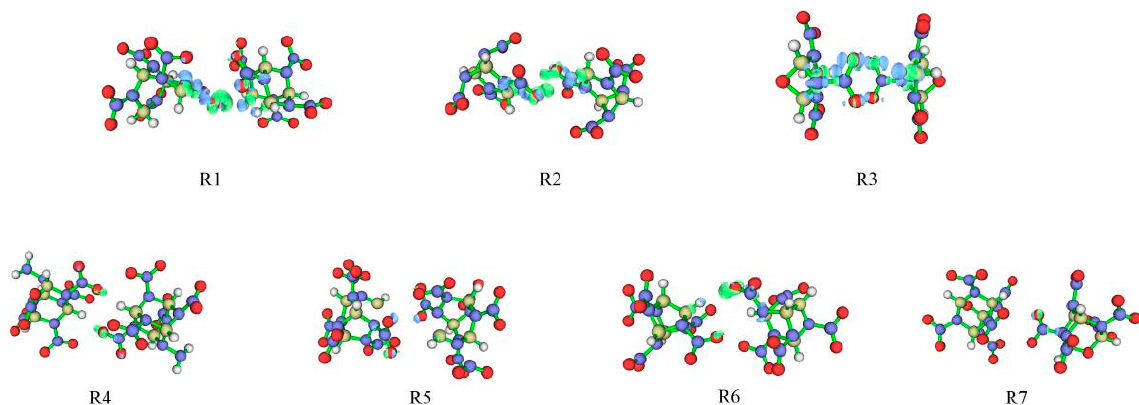
Figure 6. Electron density differences of seven bimolecular assembles.